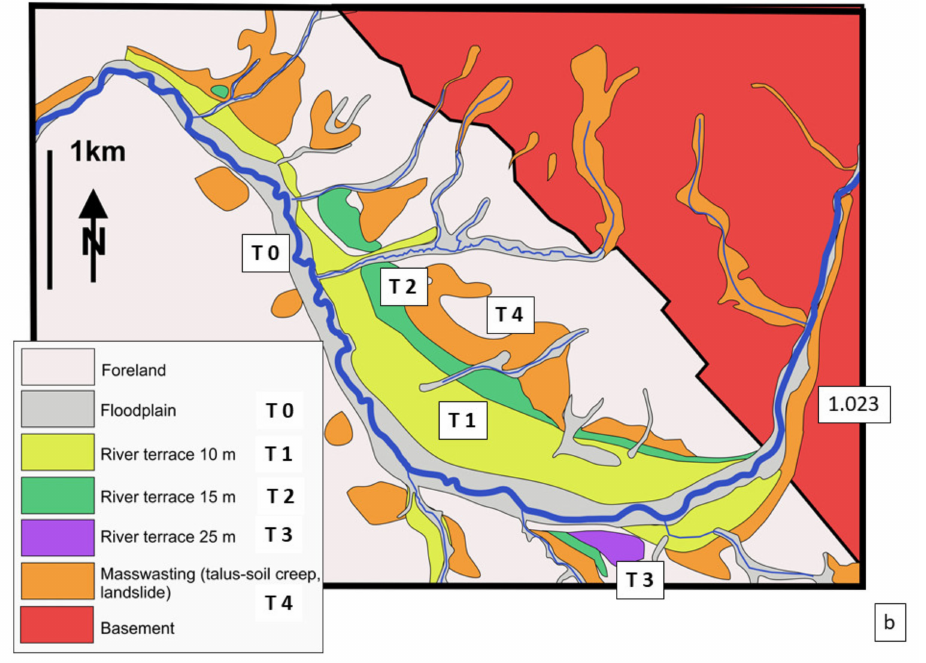
Figure 10. Litho- and morphotectonic units (MTU) characterized by the sinuosity of the Steinach drainage system and the structural geology of the bedrock in LGG-type. ( a ) The MTU of the basement CA and TA are demarcated by the dashed horizontal lines. Sinuosity is given in rectangular boxes (river sections are separated by stippled horizontal lines), full-circle rose diagram show the direction of plunge of the 2nd and 3rd order fold axes of the Fichtelgebirge Anticline (260 data). The direction of the 1st order fold axis is given as blue arrowheads. ( b ) The DA of the Steinach drainage system surrounded by a stacked pattern of depositional terraces (T1 to T4) which gradually pass into mass wasting products which were supplied by the rising basement of the Fichtelgebirge basement.